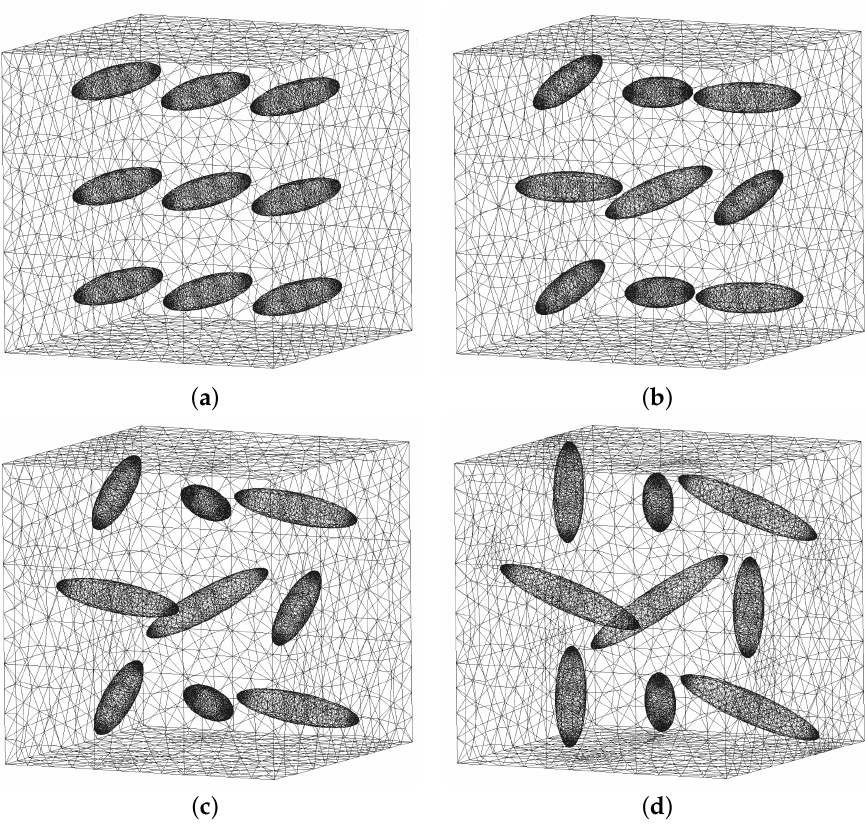
Figure 10. Periodic unit cell mesh for different fiber orientations ( a ) θ = 0 ◦ ( alignedinclusions ) ,